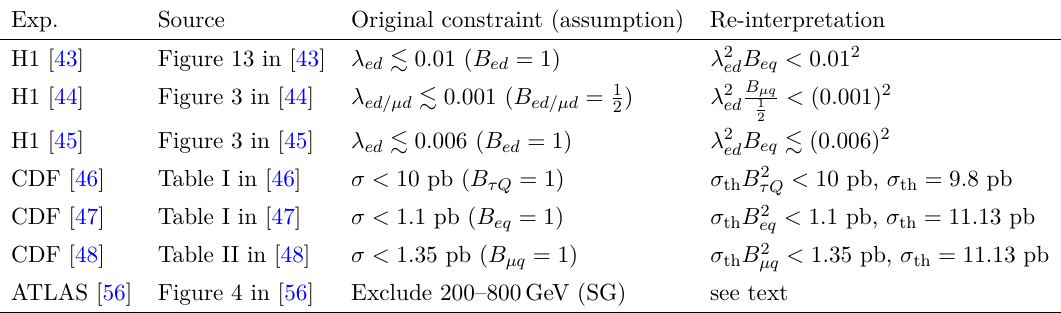
Reinterpretation of the experimental constraints on a 100 GeV LQ with an electric charge 4 e . In the table, q denotes the light down-type quarks d and s ; Q denotes all down-type 3 quarks d , s and b